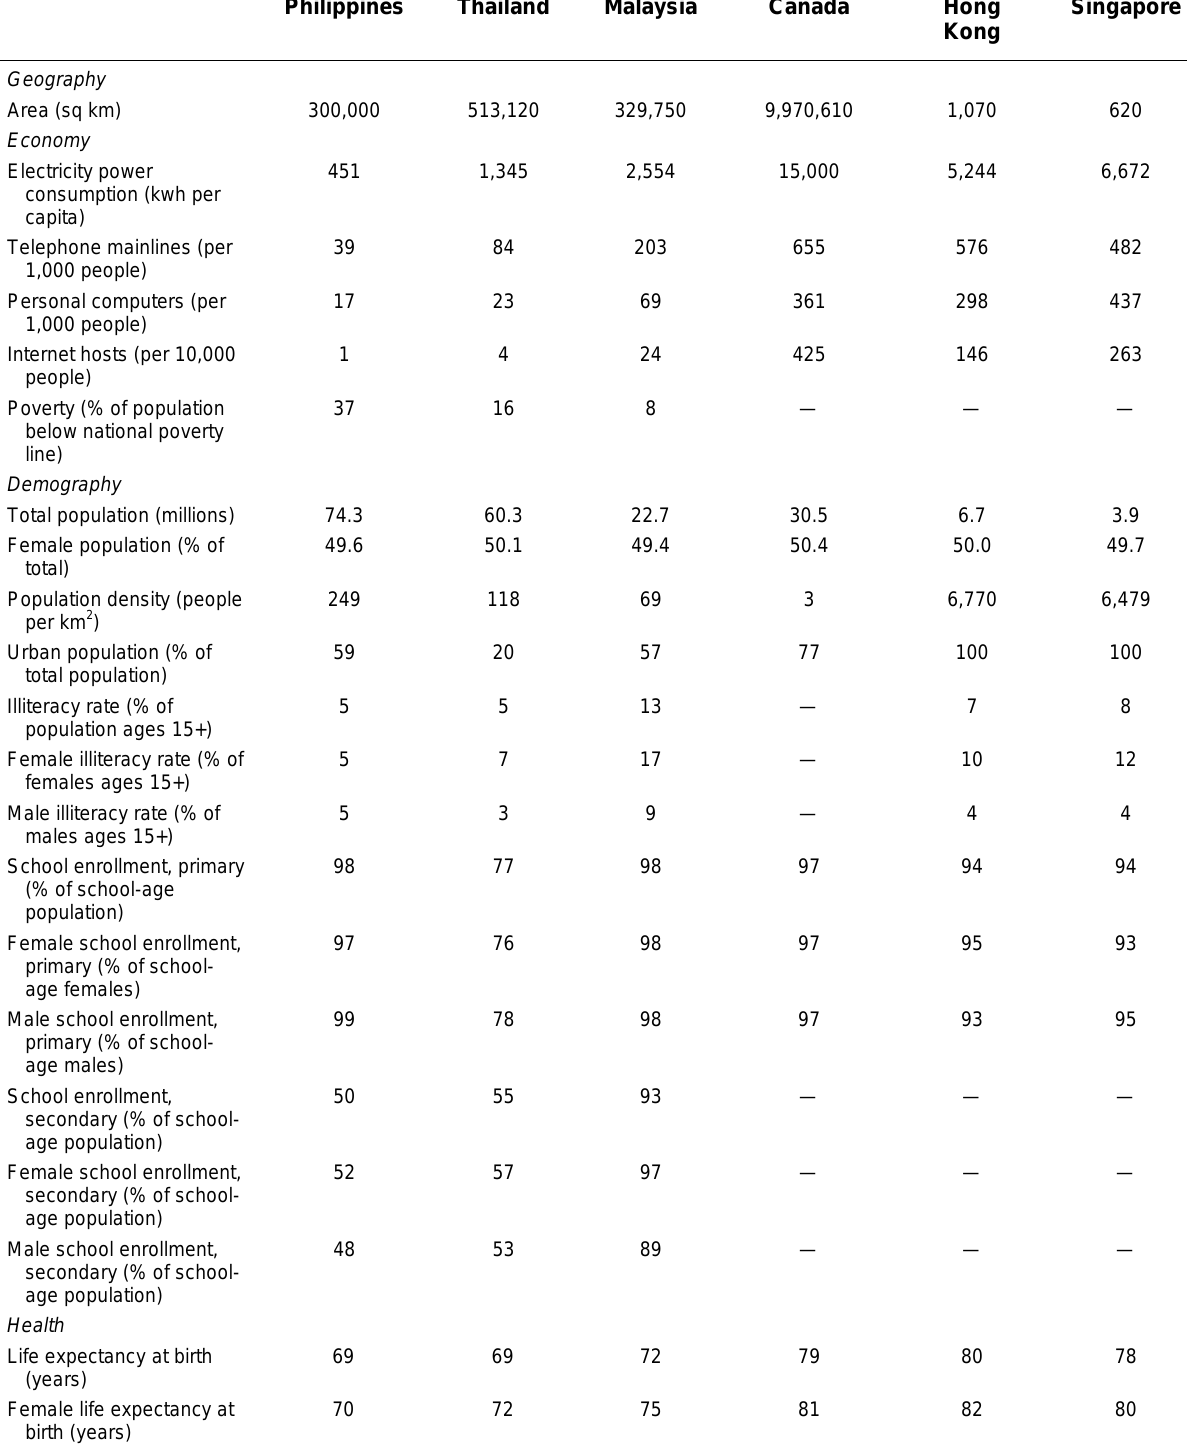
National Statistics Provided by Key Informants in the Returned Questionnaire and by Literature search, by Country/Region, Based on Most Recent Data Available at the Time of the Study (2000)*